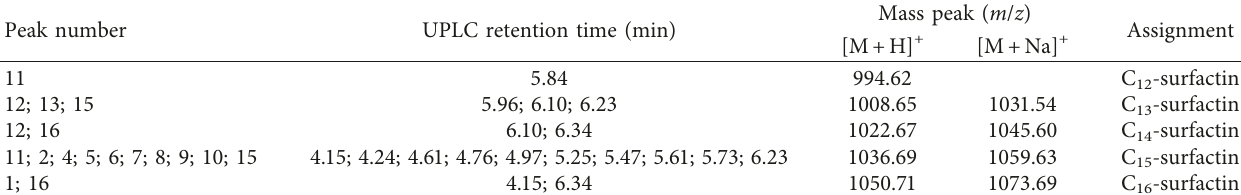
Table 1: Peak numbers, retention times, mass ion peaks, and assignment of the fatty acid moiety of surfactin. Peak number